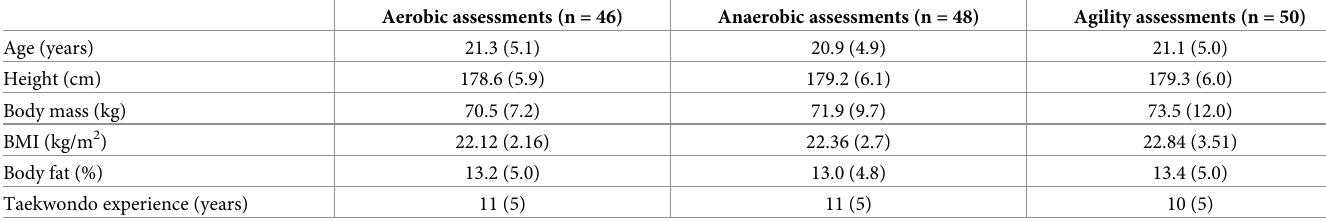
Table 1. Demographic characteristics of the athletes participating in different parts of assessments performed in this study � .